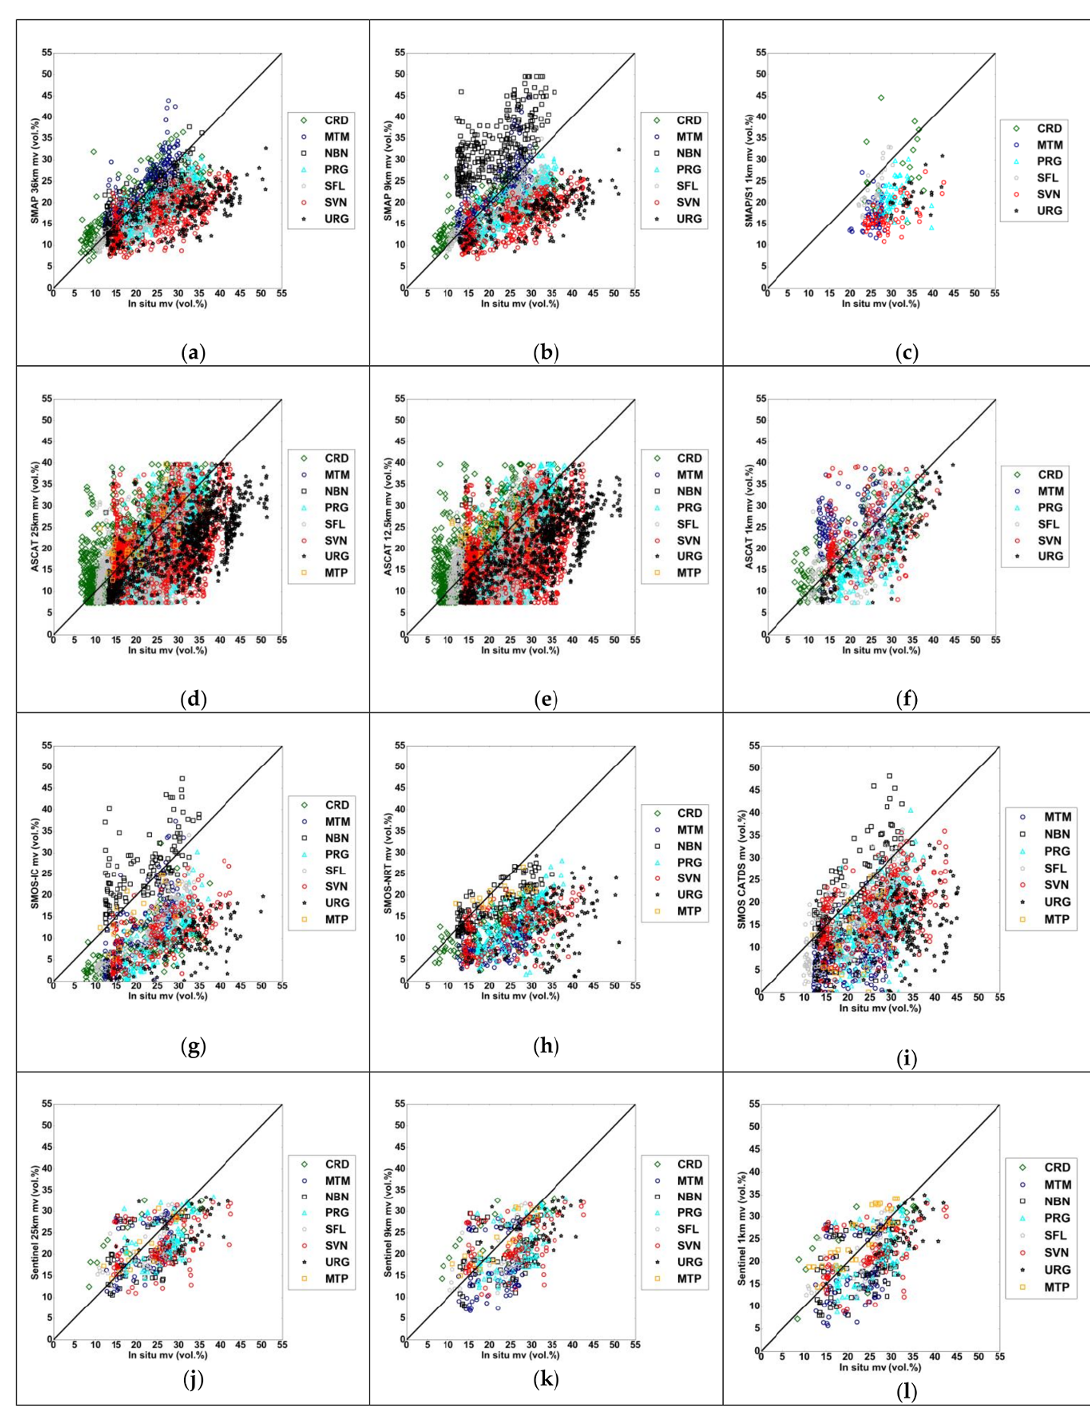
Figure 2. SSM products against in situ SSM. ( a ) SMAP-36 km (L3_SSM), ( b ) SMAP-9 km (L3_SSM_E), ( c ) SMAP/S1-1 km (L2_SSM), ( d ) ASCAT-25 km (H102 and H103), ( e ) ASCAT-12.5 km (H101 and H16), ( f ) ASCAT-1 km (H08), ( g ) SMOS-IC, ( h ) SMOS-NRT, ( i ) SMOS-CATDS, ( j ) S1-25 km, ( k ) S1-9 km, ( l ) S1-1